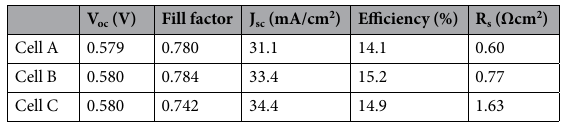
Table 2. Device performance parameters of the solar cells based on the kerfless wafers of a 48 µ m thickness with complete removal of implantation